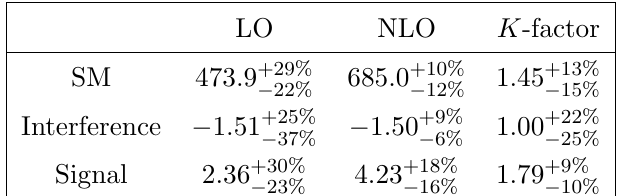
Table 3 . Cross sections for benchmark A in pb. Uncertainties are from renormalisation and factorisation scale variation.